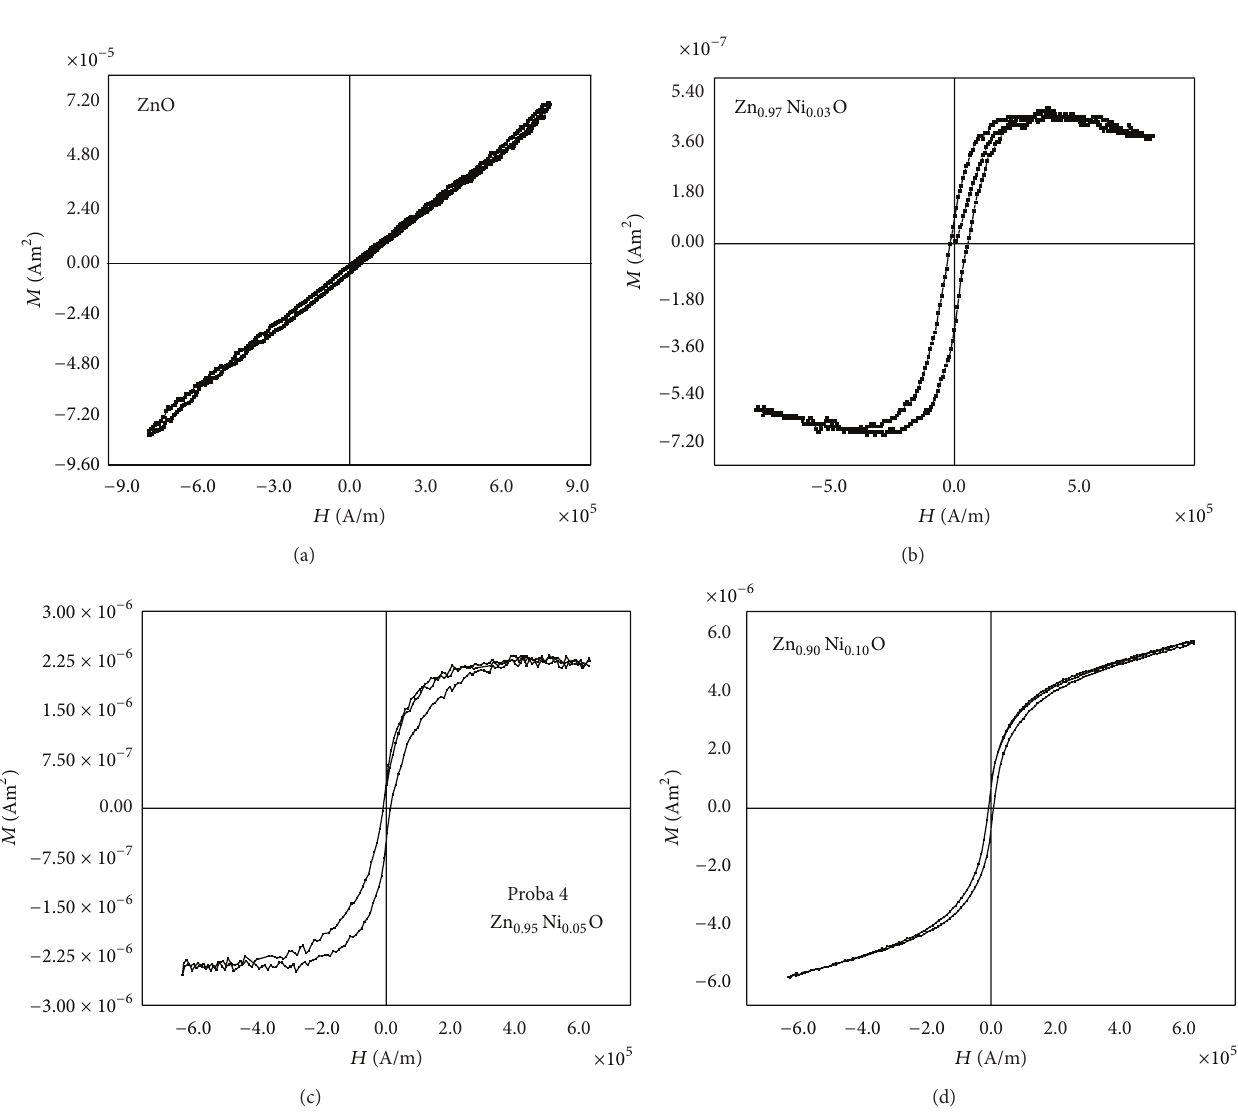
20 nm from AFM visualization of grains) and in terms of superexchange interaction between Fe octahedral (B) sites of ZnFe 2 O 4 spinel